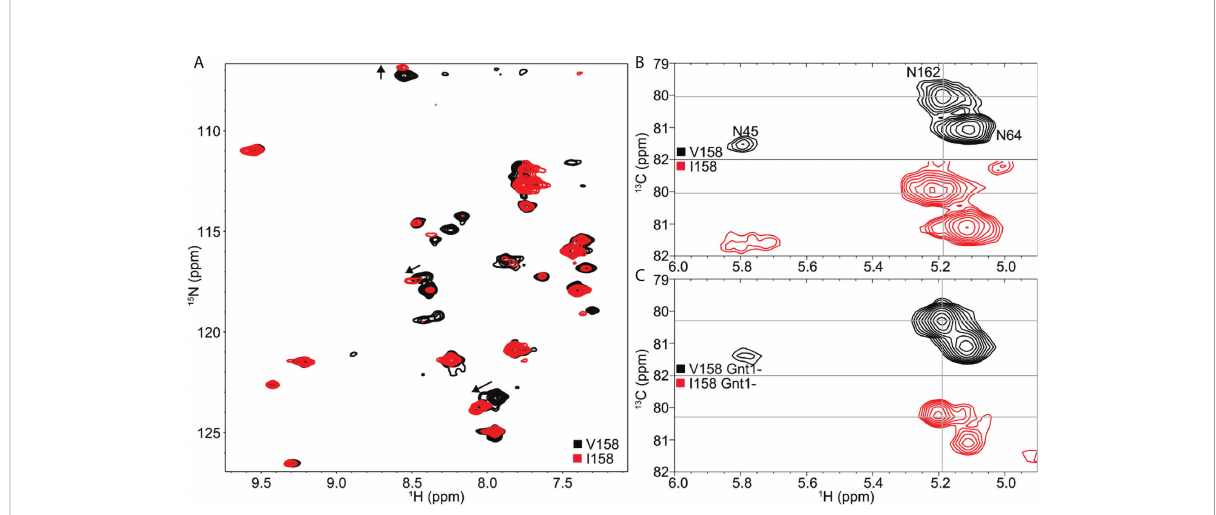
FIGURE 7 Solution NMR spectroscopy revealed subtle differences between the Mm Fc g RIII Val 158 and Ile 158 proteins. (A) 1 H- 15 N TROSY-HSQC with [ 15 N- Gly, Ser,Lys] labeling. (B) HSQC showing (1)GlcNAc 1 H 1 - 13 C 1 correlations for Mm Fc g RIII with heterogeneous complex-type N-glycans or (C) homogeneous Man5 oligomannose-type